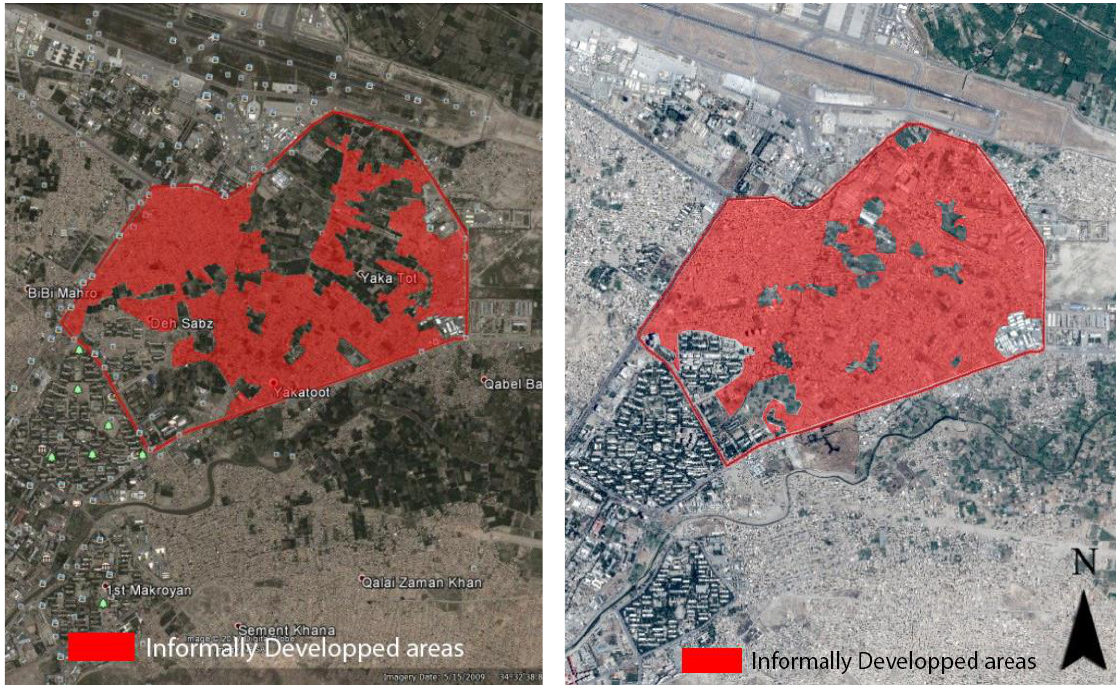
Figure 3.(a) Satellite Image of Yaktoot 2009 (UNFCCC, 2018) Figure 3.(b) Satellite Image of Yaktoot 2016 (UNFCCC,